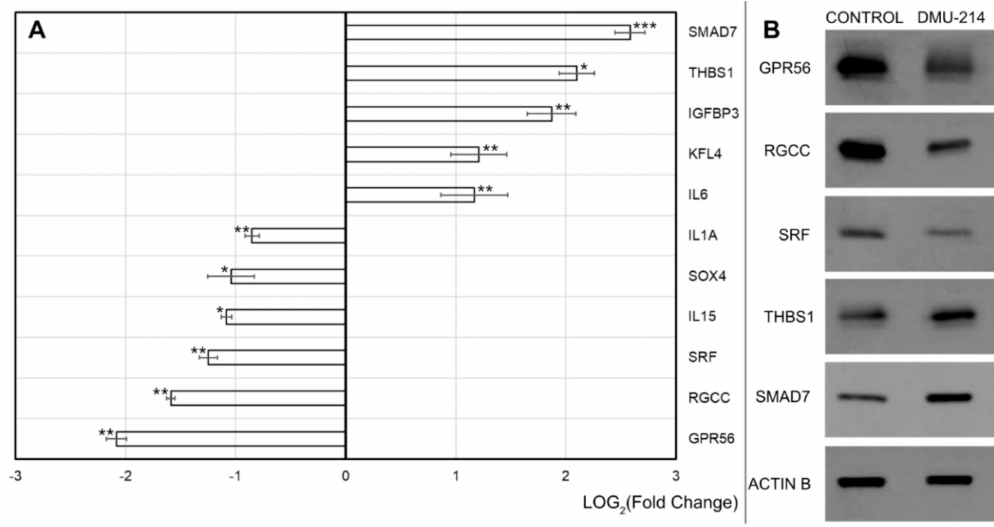
Figure 8. E ff ect of DMU-214 on migration- and proliferation-related genes and proteins in SKOV-3 cells. ( A ) Expression changes of SMAD7, THBS1, IGFBP3, KLF4, IL6, IL1A, SOX-4, IL15, SRF, RGCC and GPR56 genes in cells treated for 24 h with a vehicle or DMU-214 (0.125 µ M). RT-qPCR validation of microarray results, presented in a form of a bar graph. Fold Change was presented in its logarithmic form to provide clear comparability of the results. Results of three replicates are presented as mean ± SD. *** p < 0.001, ** p < 0.01 and * p < 0.05. ( B ) Changes of GPR56, RGCC, SRF, THBS1 and SMAD7 proteins level after treated cells for 24 h with a vehicle or DMU-214 (0.125 µ M). Western blot was performed to validate microarray and RT-qPCR